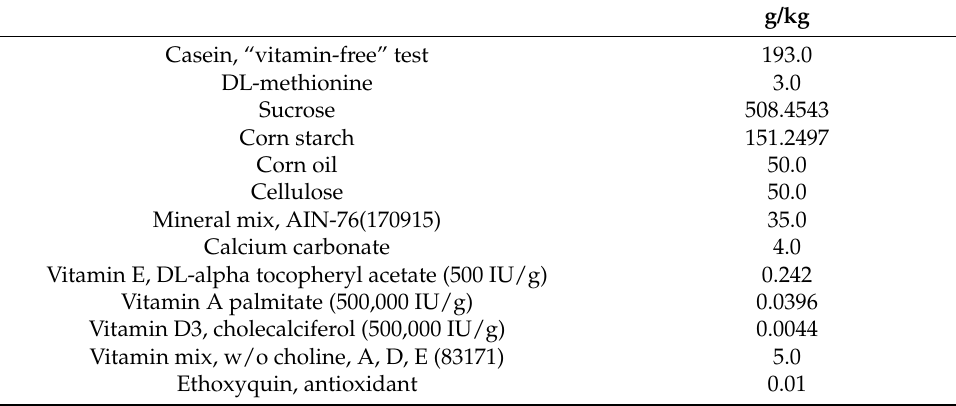
Table 2. Choline-deficient diet. After the adaptation period, mice were fed either a choline-deficient diet or a normal diet with 1% choline chloride. The experiment was carried for 2–4 weeks, and during the experimental period, the blood of the mice was sampled from the eyes on 0, 7, 14, and/or 28